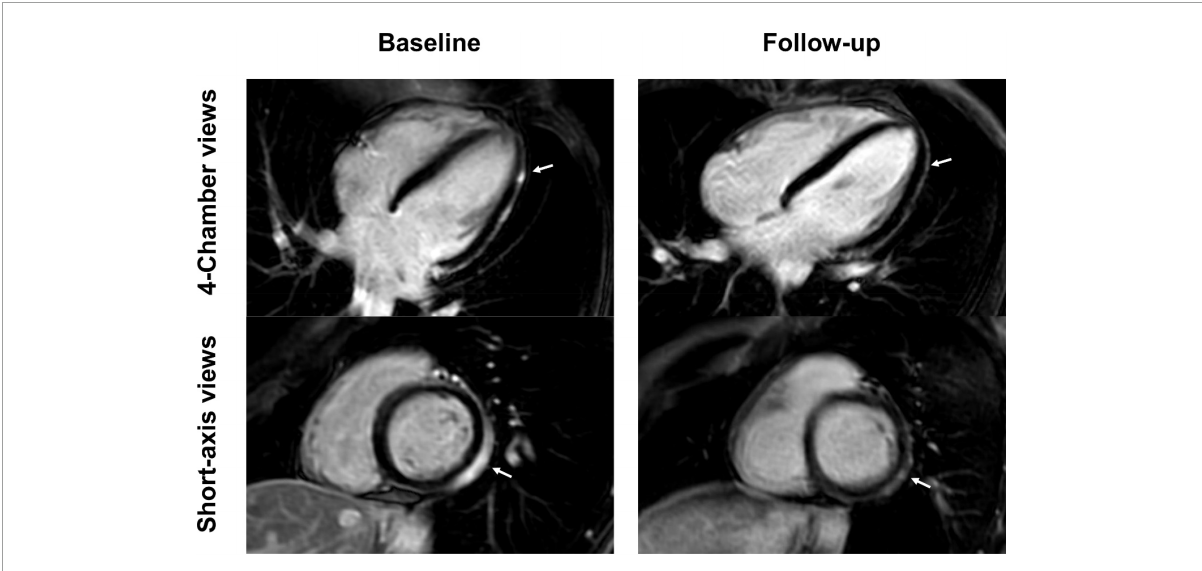
FIGURE3 Short-axis and 4-chamber late gadolinium enhancement (LGE) views in a 28-year-old, previously healthy male after receiving his second Moderna vaccine. Reduction of subepicardial enhancement along the lateral wall from baseline (arrows) to follow-up 11-months later consistent with myocardial scarring. This patient reported new onset of occasional exertional dyspnea after initial acute vaccine associated myocarditis.